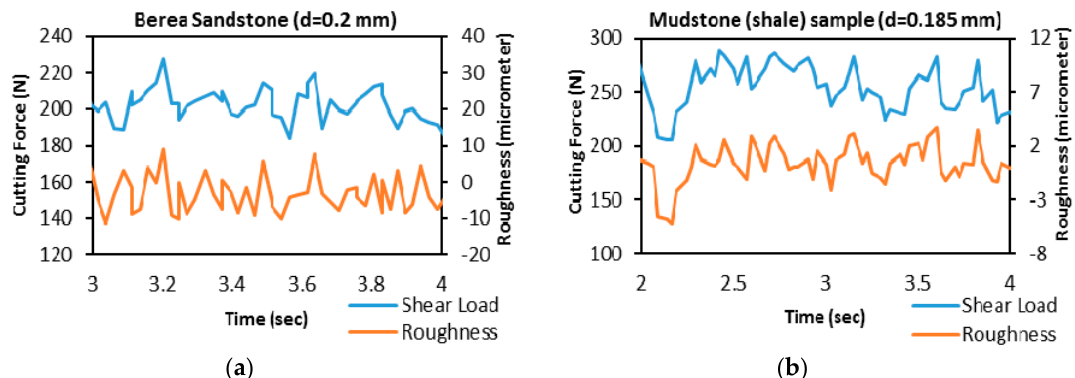
Figure 5. The shear force and the groove roughness variation during the cutting process: ( a ) Berea sandstone (DOC = 0.2 mm), ( b ) Mudstone (DOC = 0.185